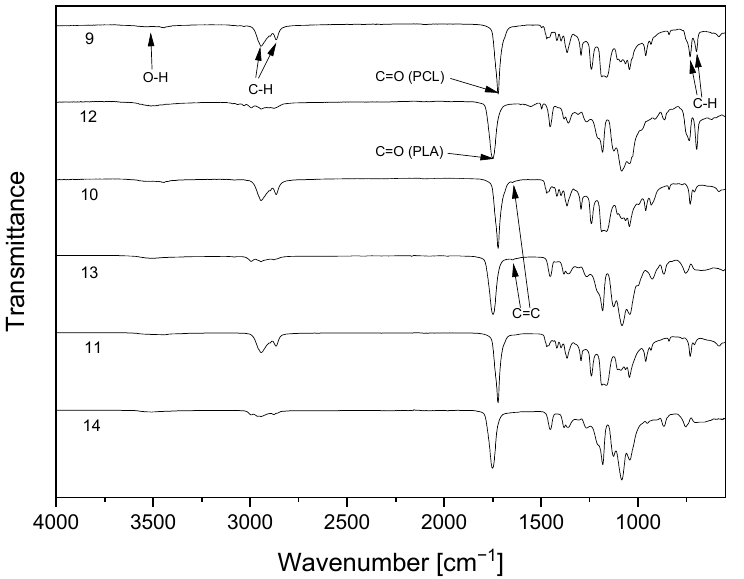
Figure 3. FTIR spectra of cellulose-based copolymers with poly( ε -caprolactone) (9–11) or poly(L- lactide) (12–14)